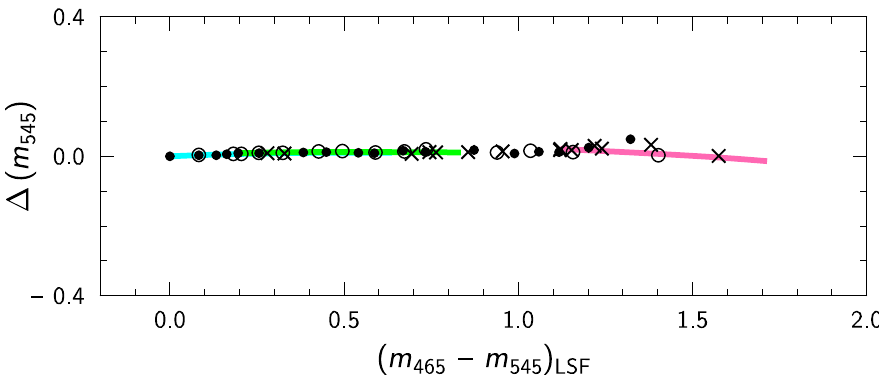
Fig. 8f. Decontamination corrections for the magnitude m 545 .